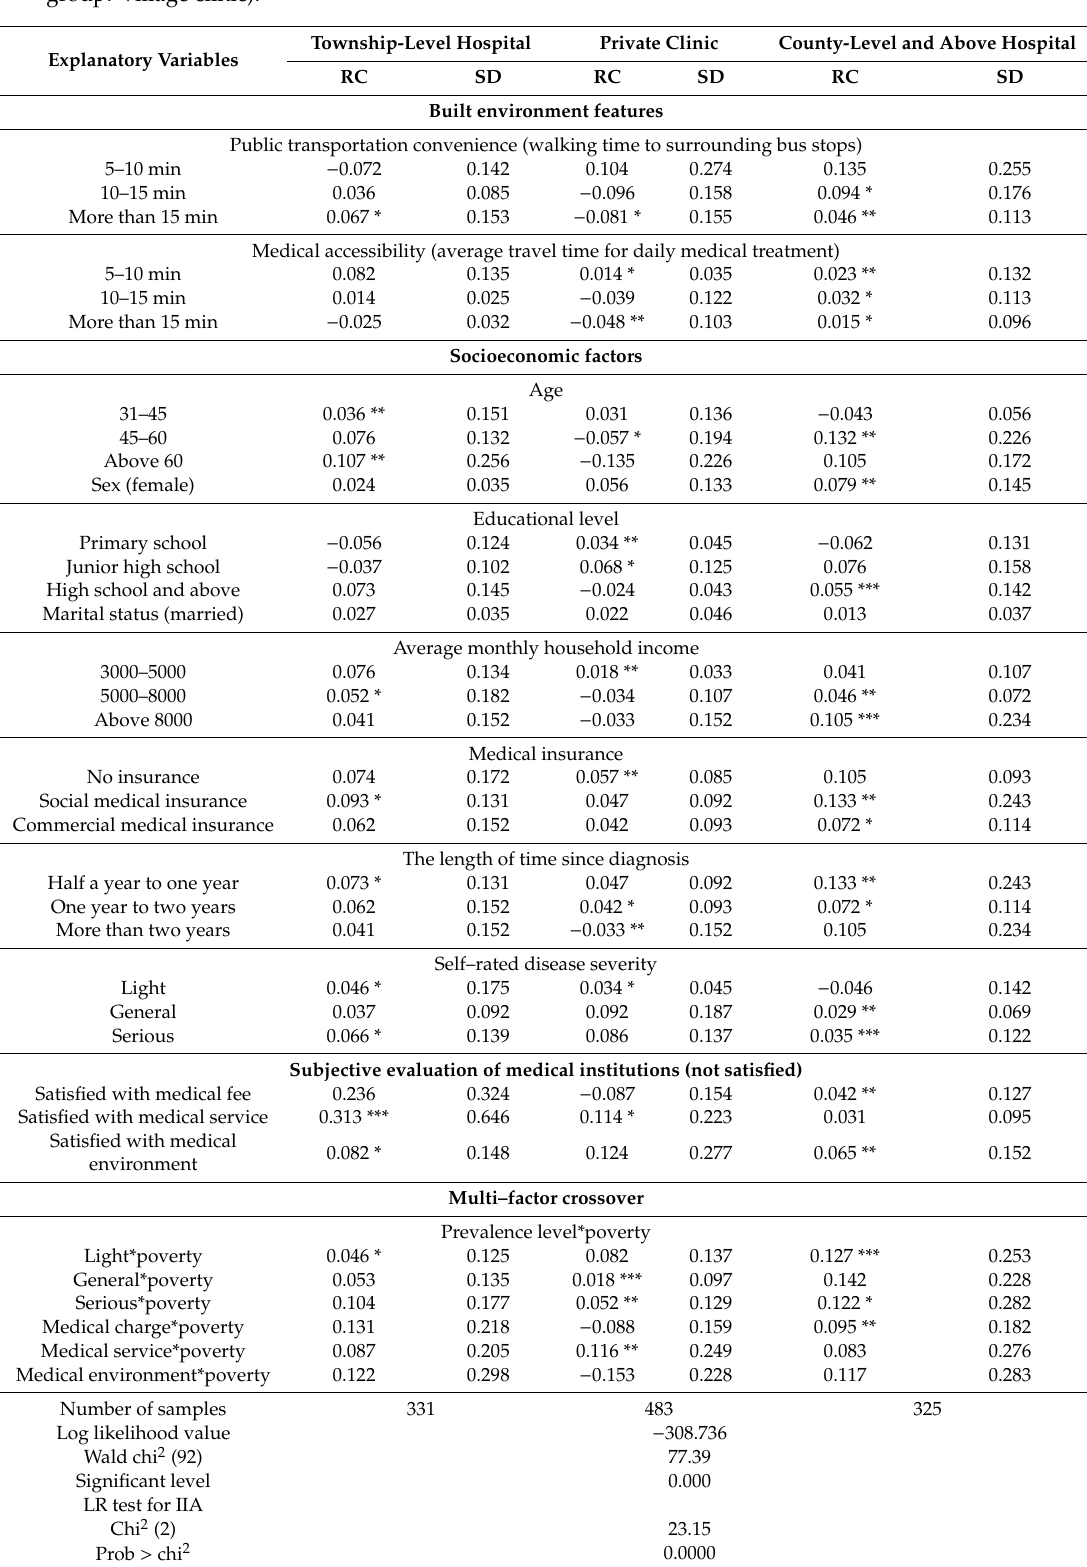
Table 6. Nested multiple logit model results of the chronic disease patients’ chosen institutions (control group: Village